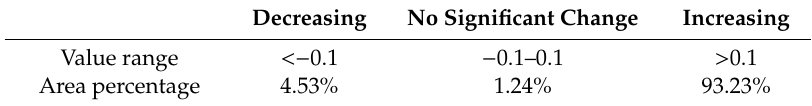
Figure 6. Change of seasonally integrated normalized di ff erence vegetation index (SINDVI) in the TGRC from 2000 to 2015. Table 4. Proportion of areas with di ff erent vegetation change in the TGRC from 2000 to 2015.